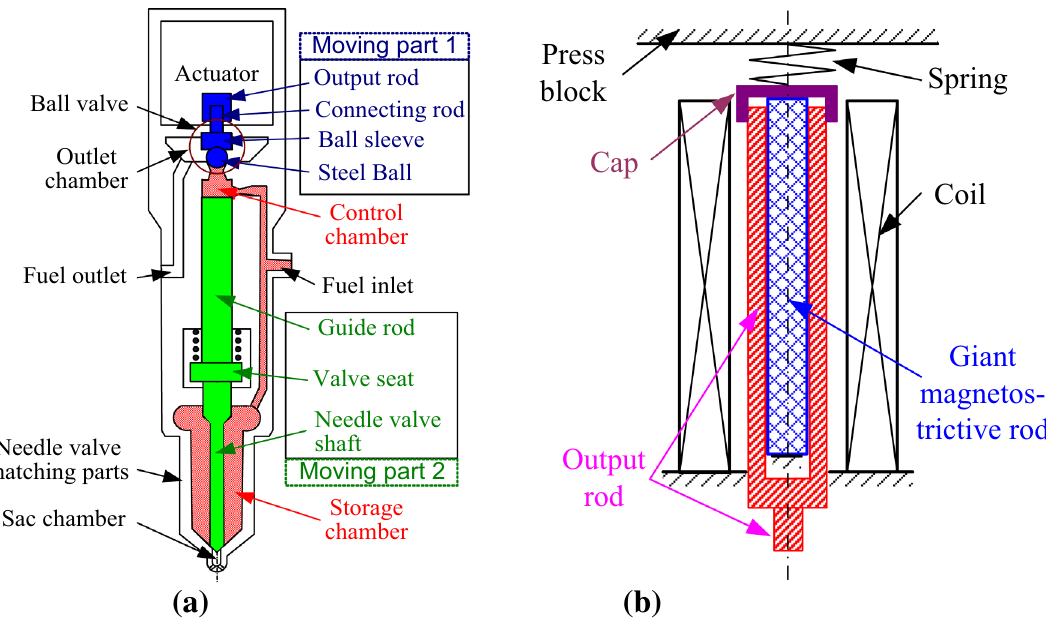
Figure 1. Structure profile of the GMI: ( a ) structure drawing of the whole injector; ( b ) structure drawing of the actuator